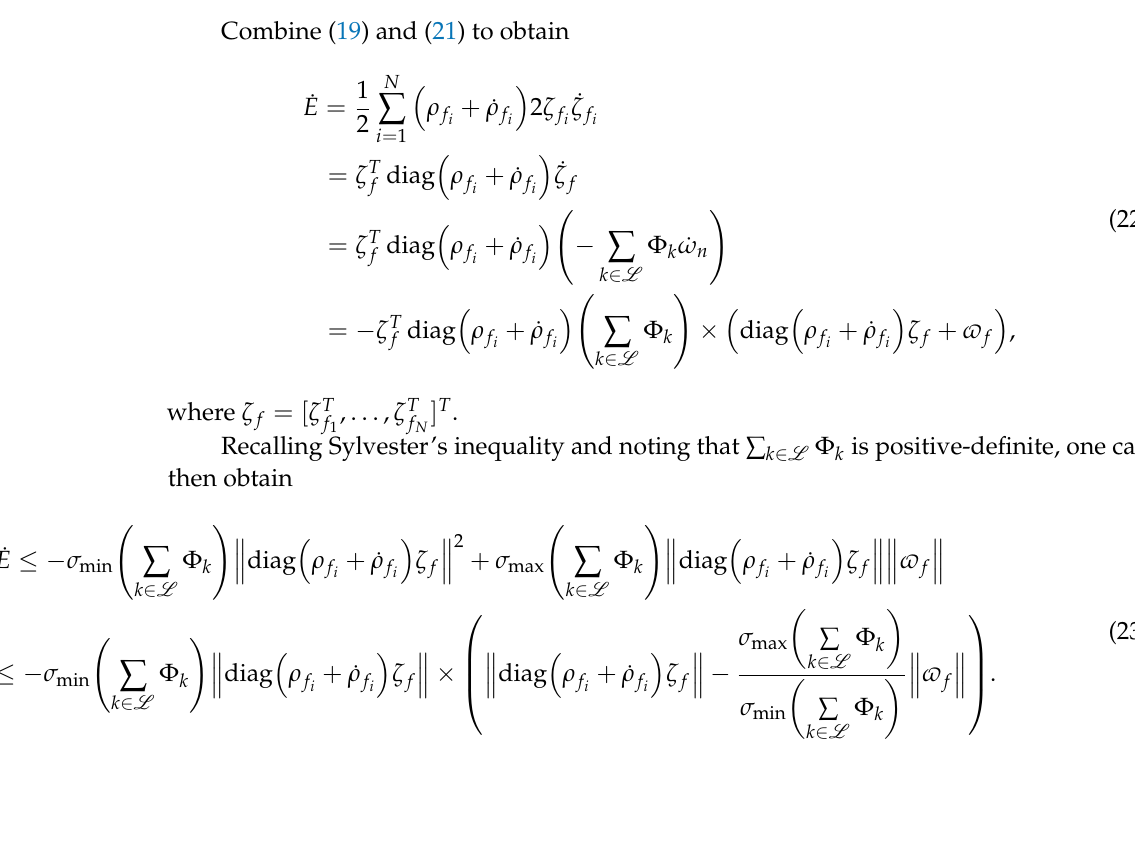
Figure 2. Communication layer among inverters and the proposed attack-resilient secondary control framework for an